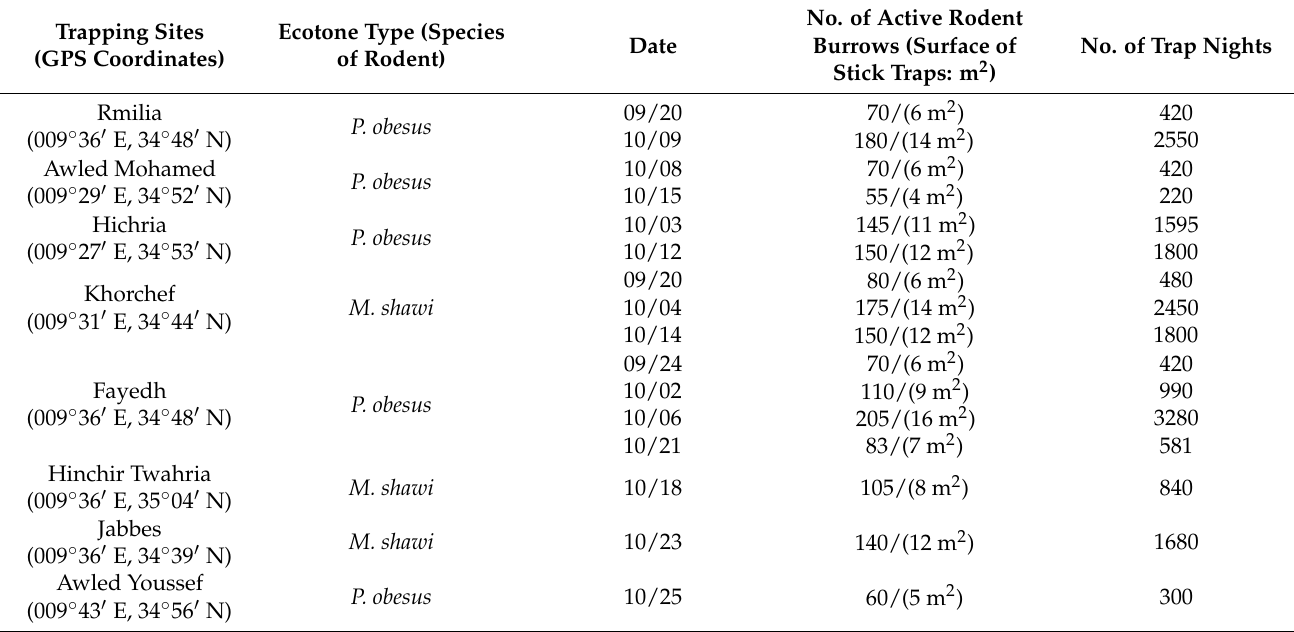
Table 1. Trapping of sand flies from different